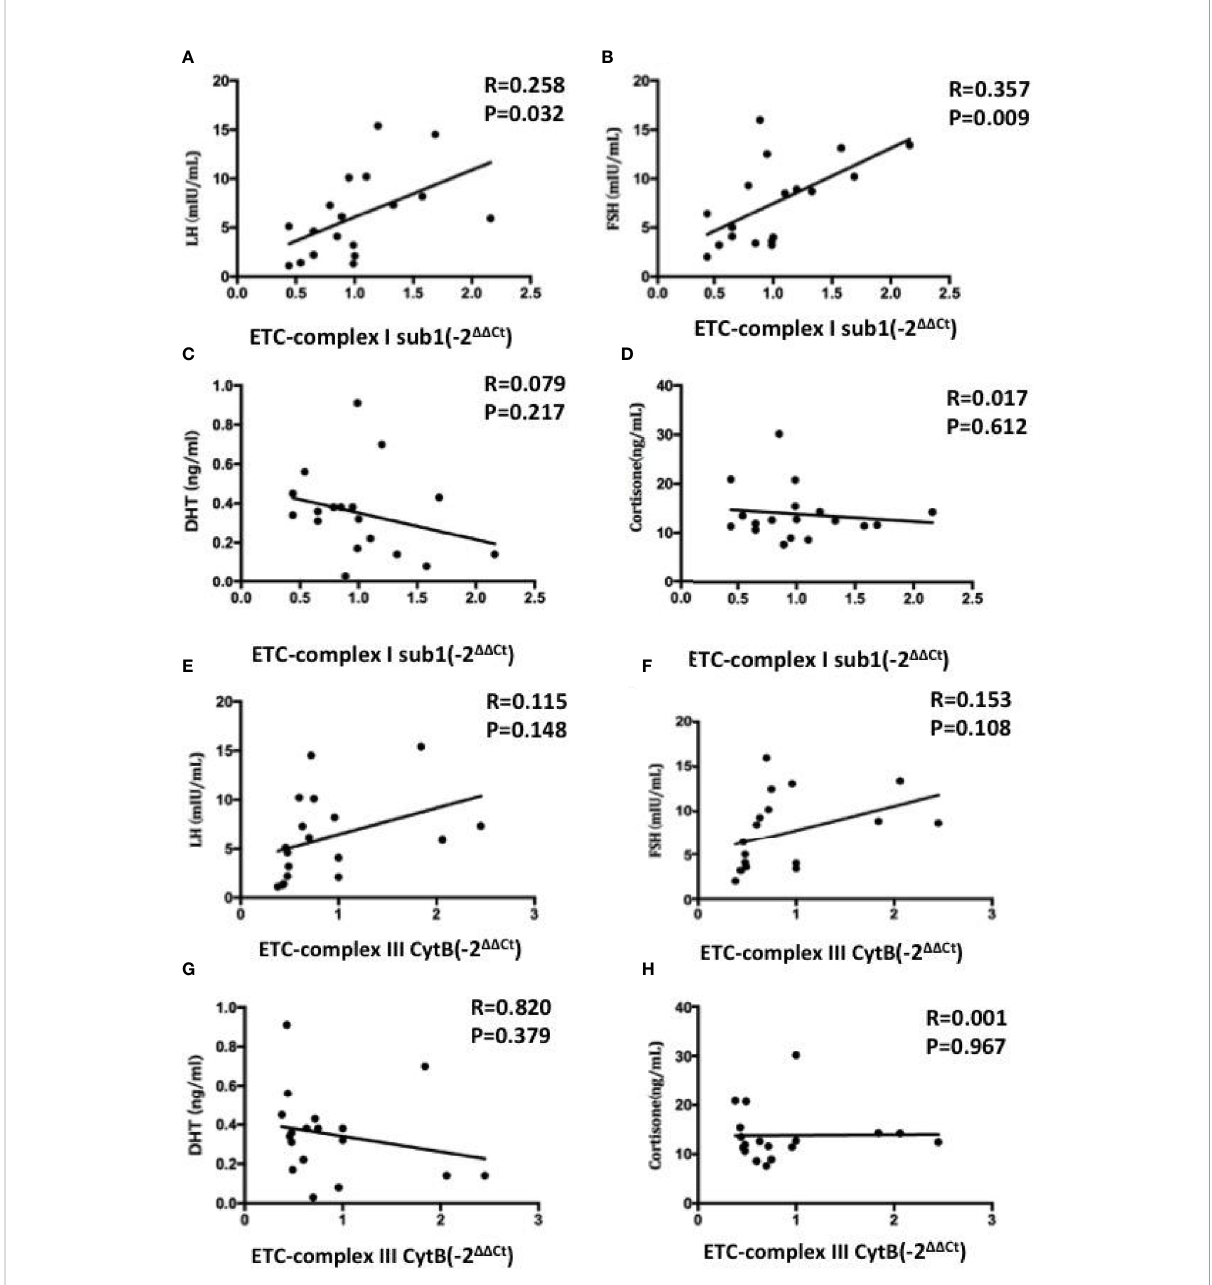
FIGURE 6 Correlations between the mRNA expression levels of mitochondrial ETC genes in FF exosomes with LH (A, E) , FSH (B, F) , DHT (C, G) and cortisone (D, H) levels. Pearson test was used for normally distributed variables, and Spearmen test was used for non-normally distributed parameters. Values are signi fi cant at p <